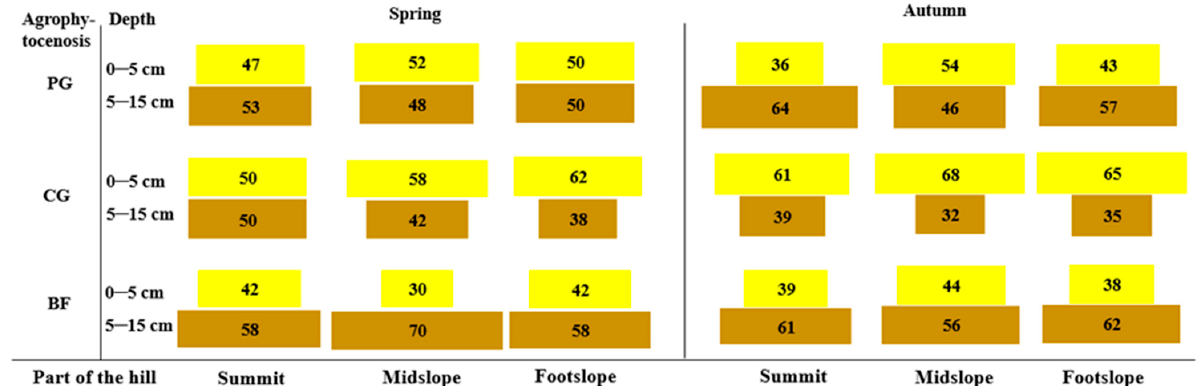
Figure 2. Vertical distribution of soil seed bank (%) in 2020–2021. PG—permanent grassland; CG— cereal–grass crop rotation; BF—crop rotation with black fallow.